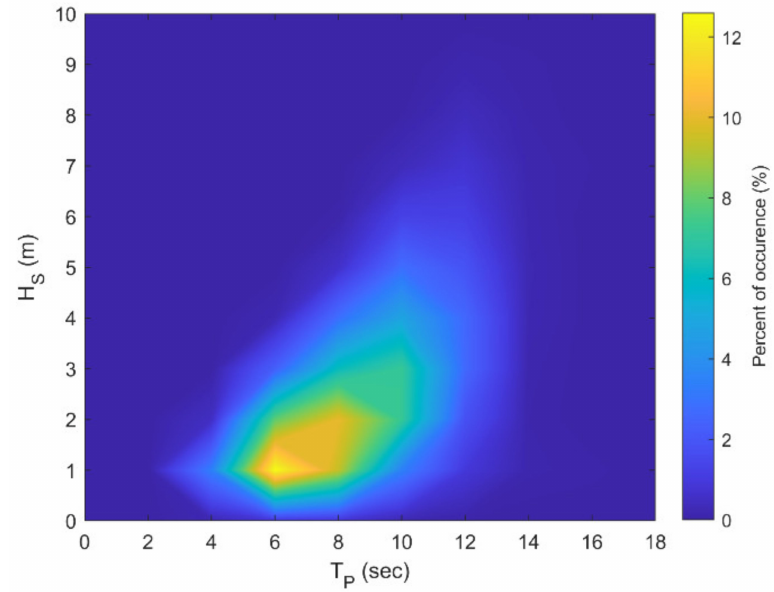
Figure 4. Scatter diagram of the northern route from the British Channel to the west coast of the